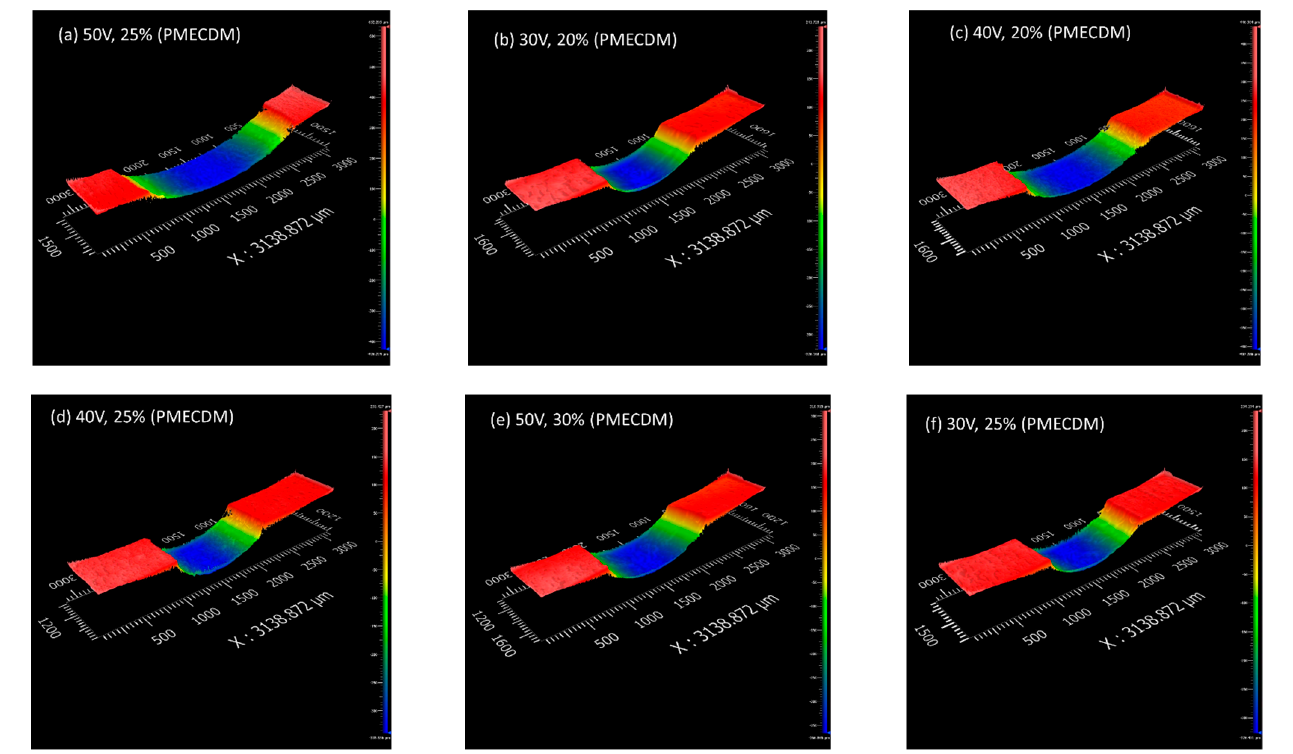
Figure 6. Three-dimensional surface profiles of holes prepared using PMECDM.